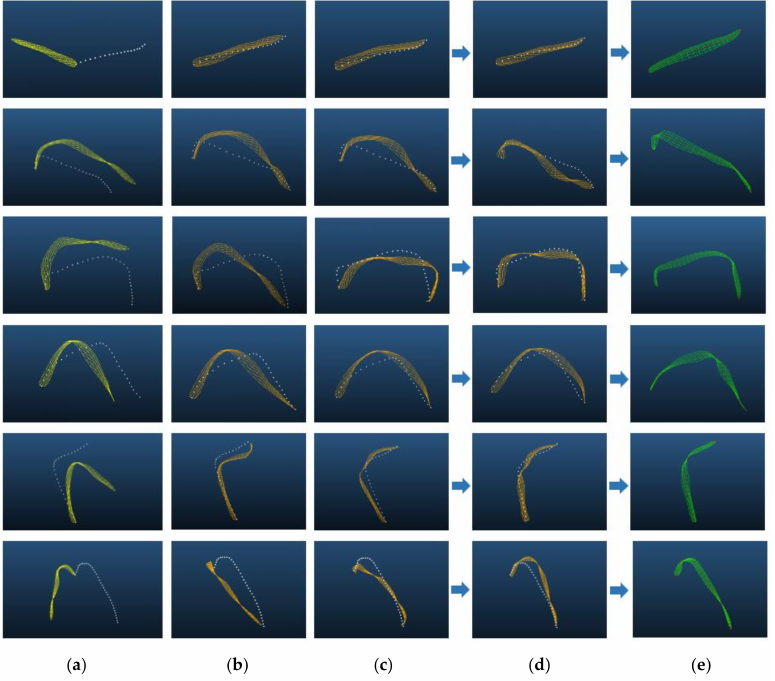
Figure 9. Mesh deformation process and results of six typical leaves. ( a ) Target vein and matched template leaf; ( b ) Using only one control point at the leaf tip; ( c ) Five iteration results; ( d ) Ten iteration results; ( e ) Final